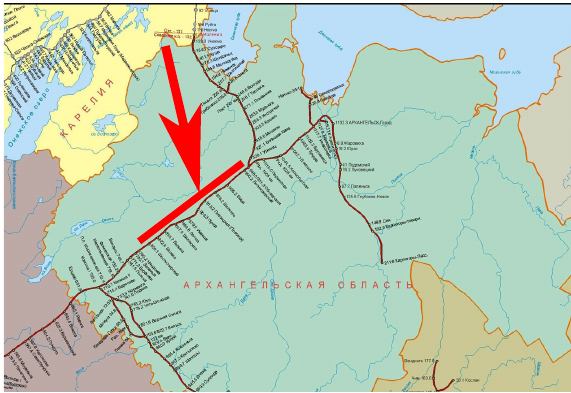
Fig. 3. Nyandoma part of the Northern railway reported on failures in the automatic control systems. In the upper portion one can see a part of Northern Ice